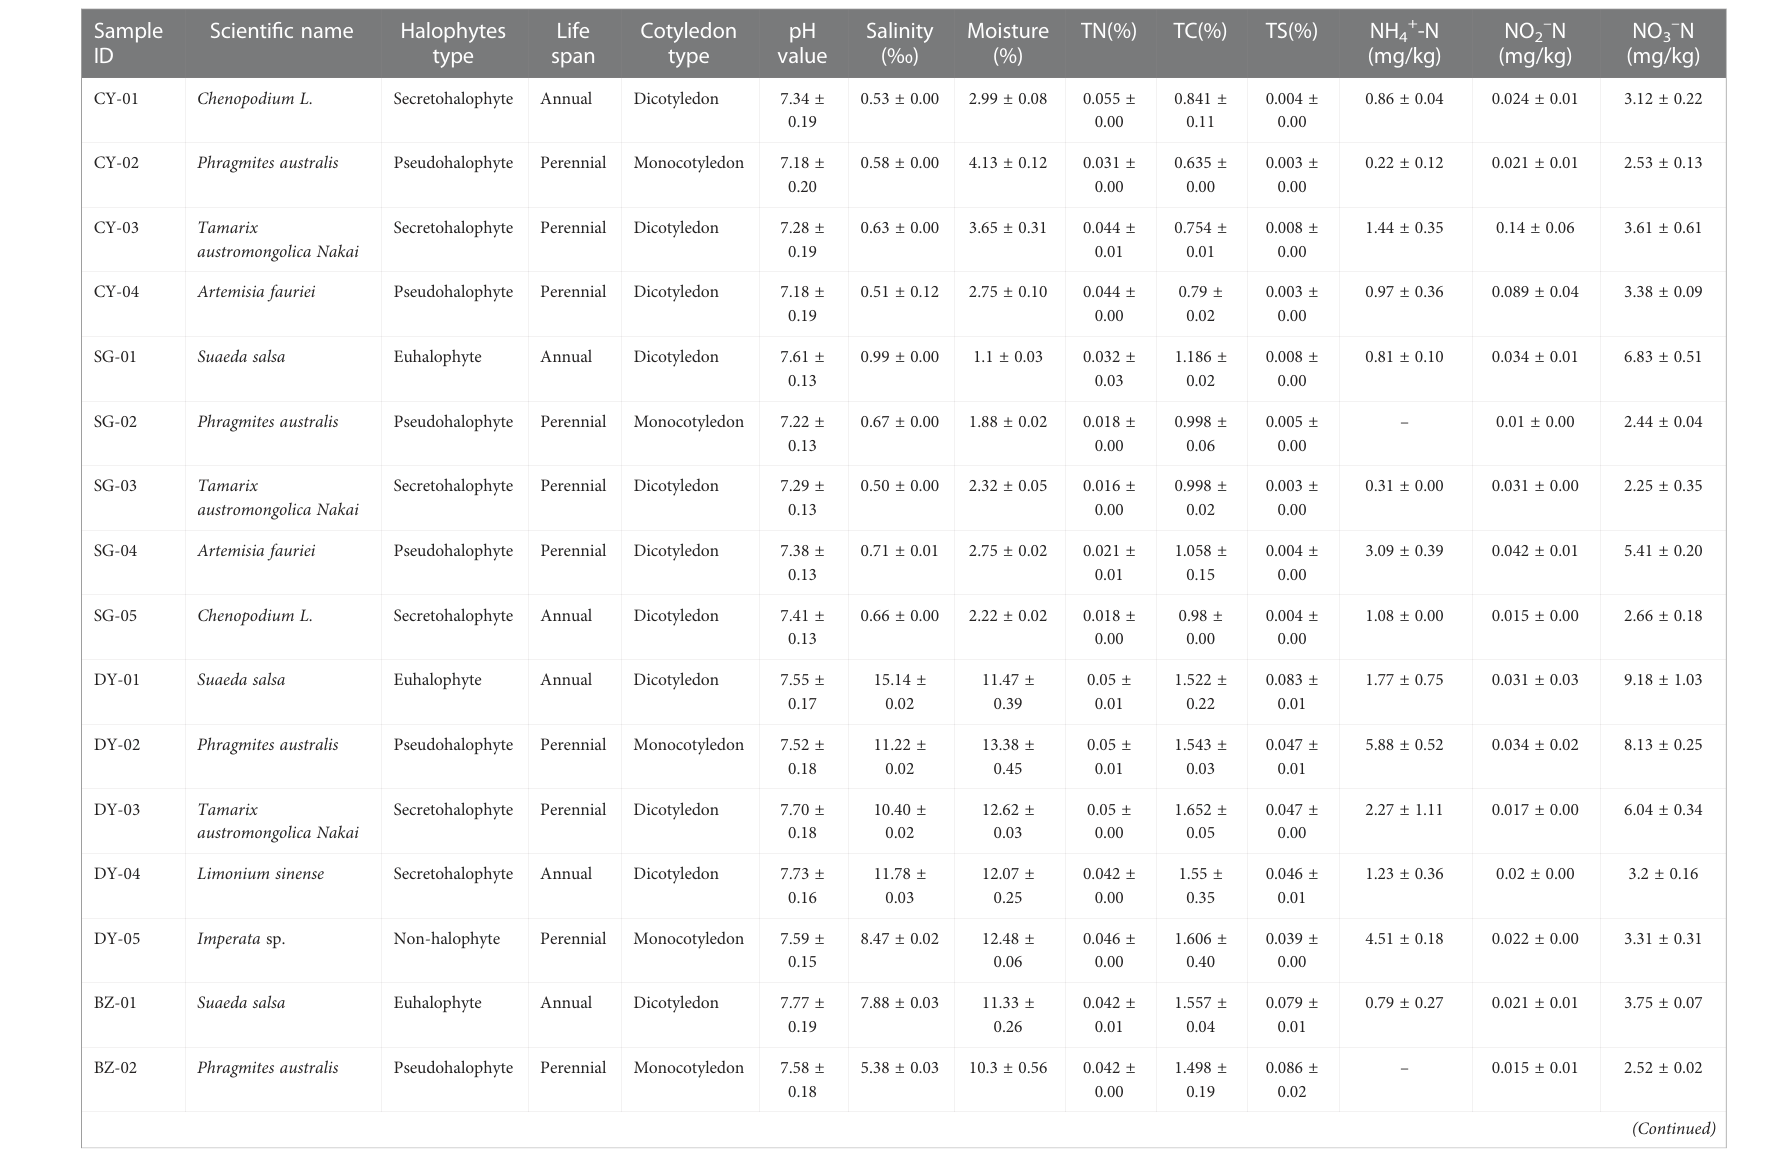
TABLE 1 Characteristics of host plants and rhizospheric